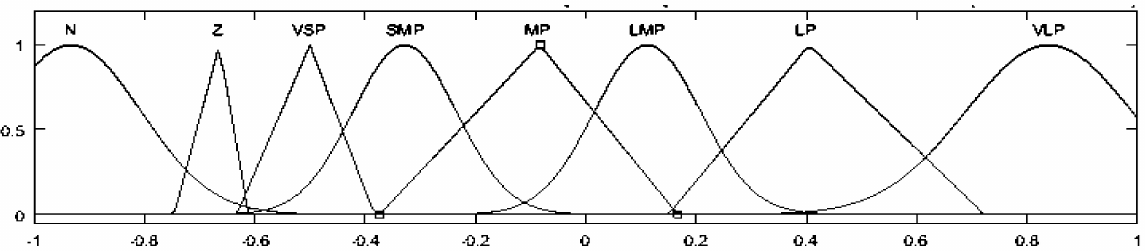
Figure 12. V de and V qe - Input membership function of error.